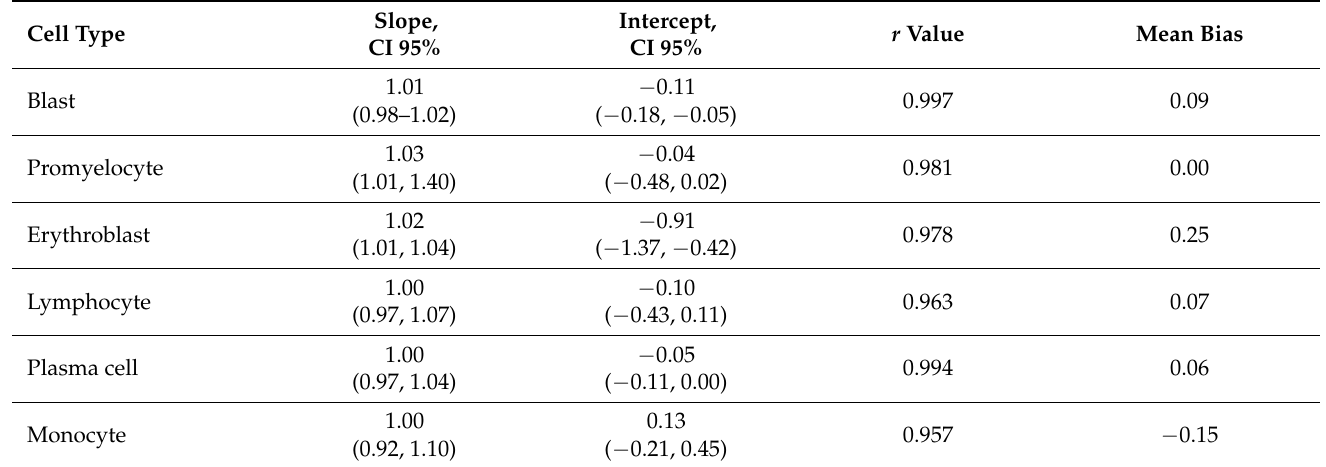
Table 5. Comparison analysis between BMCS 200-cell and 500-cell DCC results for the complete set ( n = 550) according to cell type, using Deming Linear Regression.